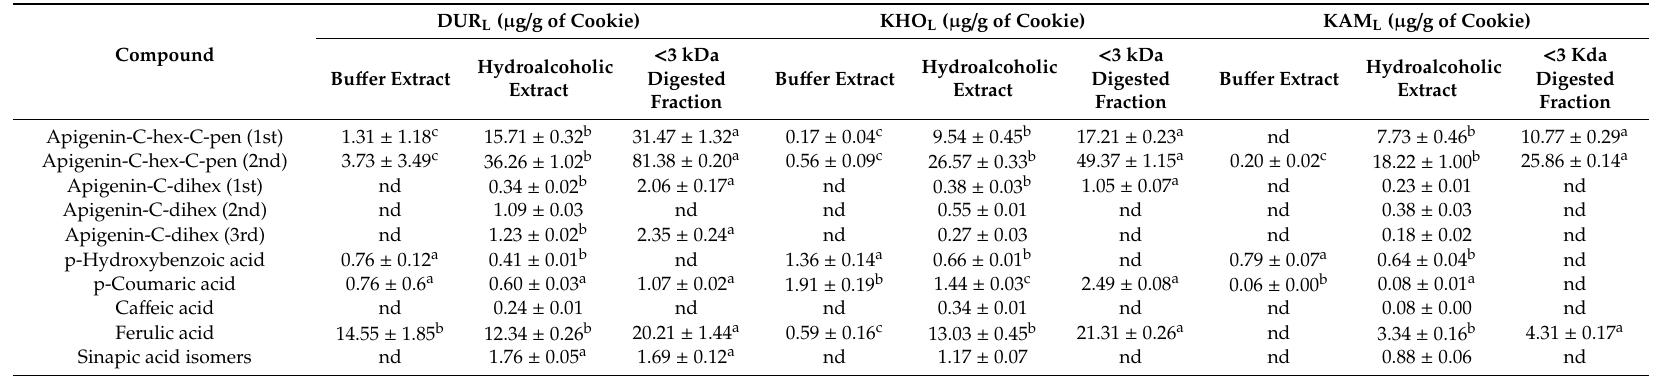
Table 3. Concentration of the main free PCs in the experimental cookies prepared using sourdough fermentation. Values are expressed as mean values ± SD (n = 4 for the chemical extracts, n = 3 for the digested samples). The statistical analysis was performed using one-way ANOVA followed by Tukey’s HSD test. For each cookie type, di ff erent letters in the same row indicate statistical significance ( p <